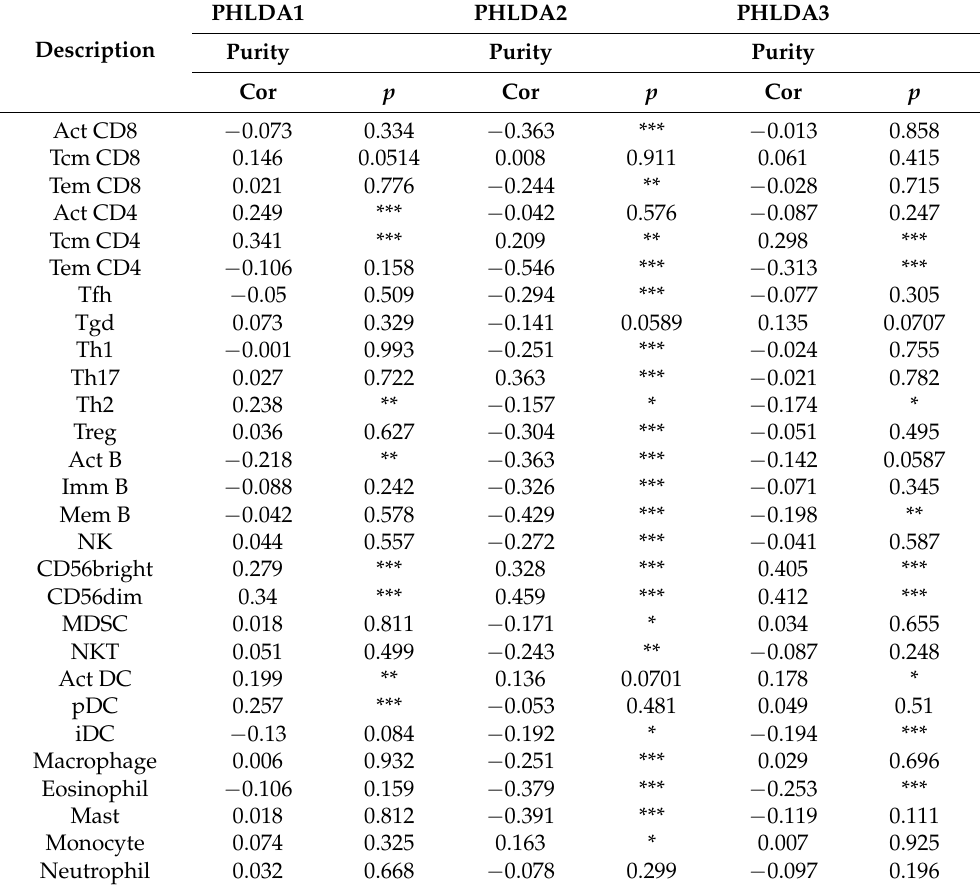
Table 1. Relationship between PHLDA family expression and the abundance of tumor-infiltrating immune cells in